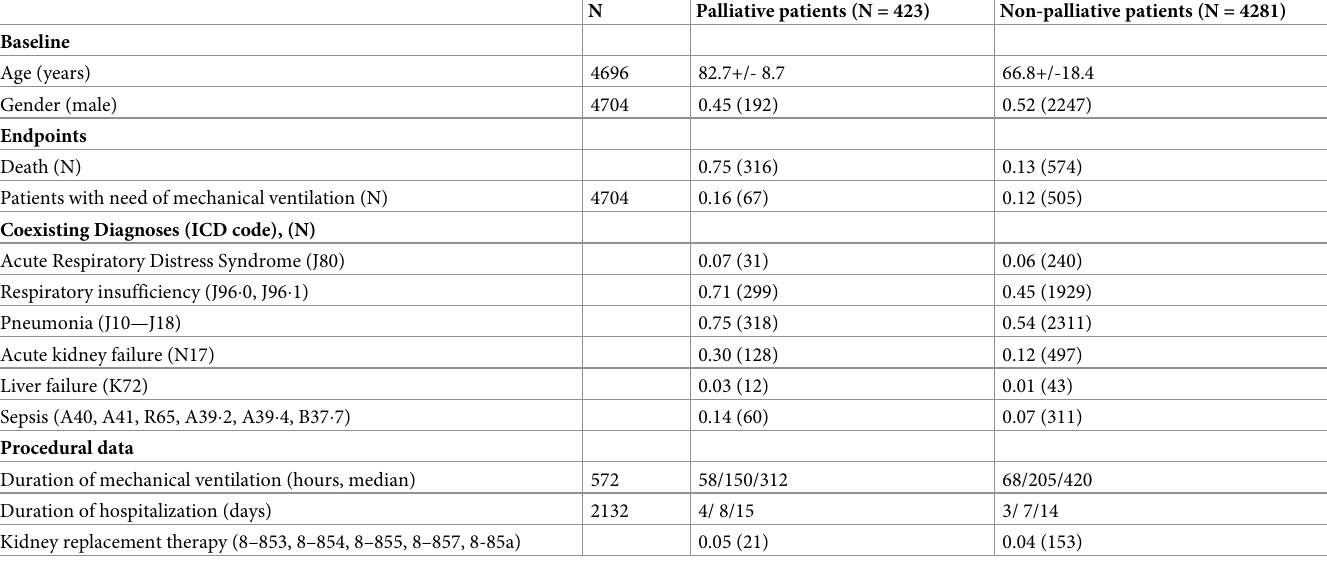
Model development. The primary endpoint was analyzed in an ordinal fashion, recording the worst of the following three states: death for non-survivors, severe cases as the need for ventilation or ICU admission for survivors, or mild state as discharge from a non-ICU ward. Table 2. Patient characteristics for patients receiving palliative care (palliative patients) and patients not receiving palliative care (non-palliative patients) (N = 4704). N Palliative patients (N =